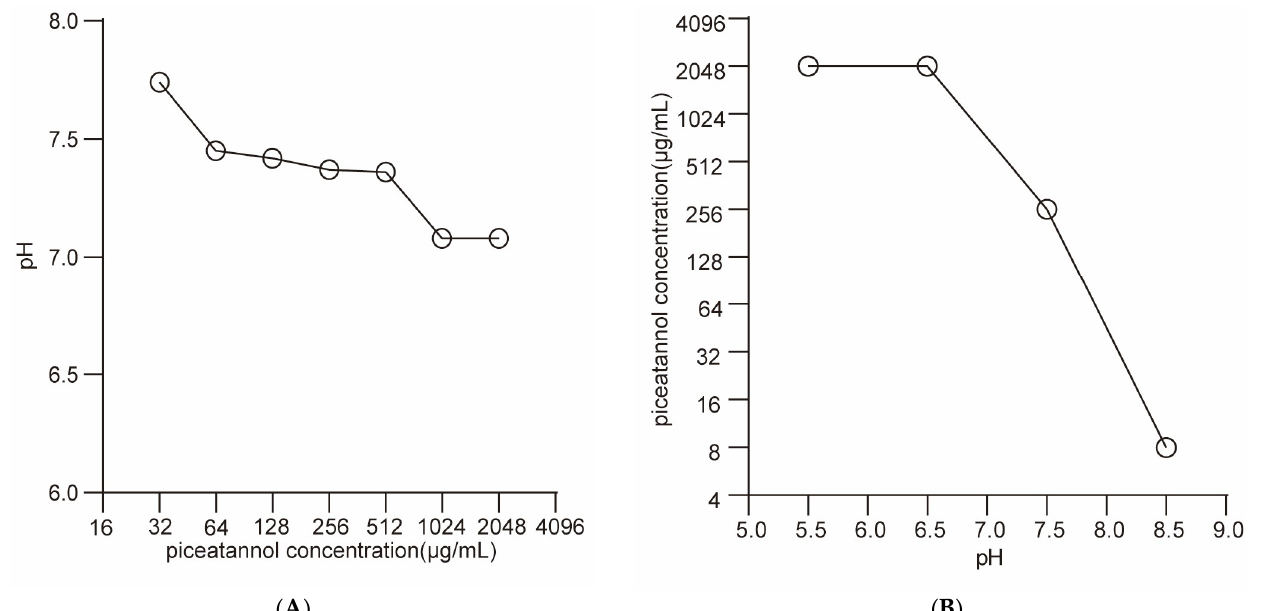
Figure 5. Effect of pH on the ability of PIC to dissipate S. aureus ATCC 29213 PMF. ( A ) pH of PBS with different concentrations of PIC. ( B ) MBC of PIC against S. aureus ATCC 29213 at different pH. n = 3. Results from all experiments are presented as the mean ± SD of three replicates.